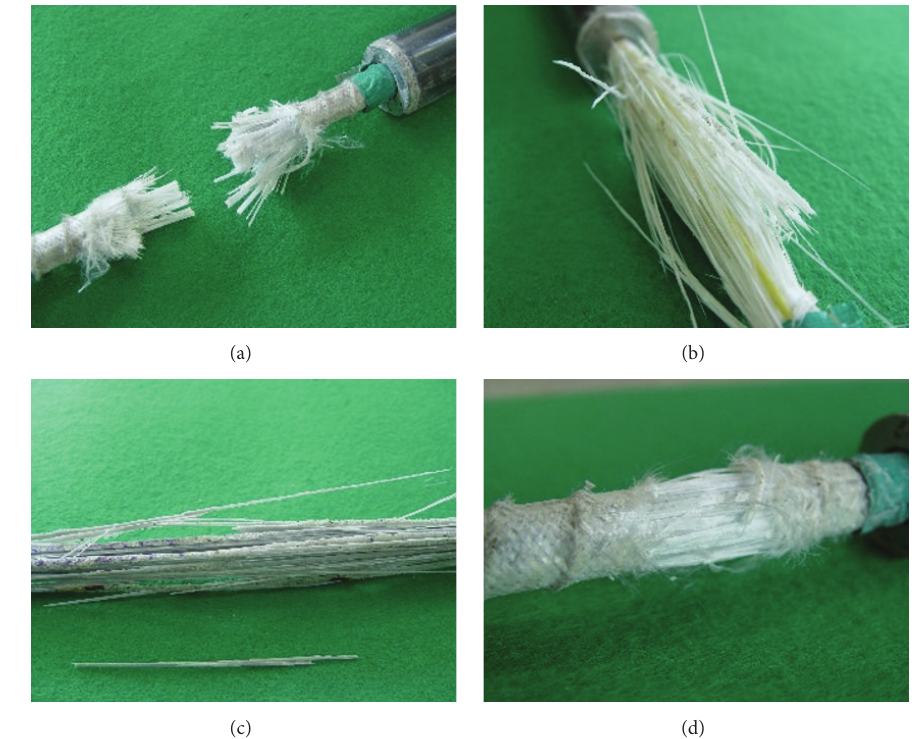
Figure 18: Failure modes [24]: (a) KICT bar; (b) Aslan 100; (c) V-Rod; and (d) FRP Hybrid